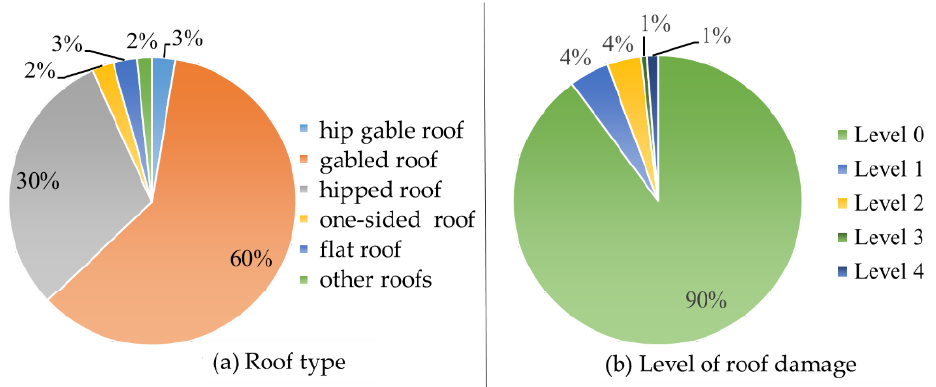
Figure 7. Composition of training sample. ( a ) Proportion of roof types in training data. ( b ) Proportion of level of roof damage in training